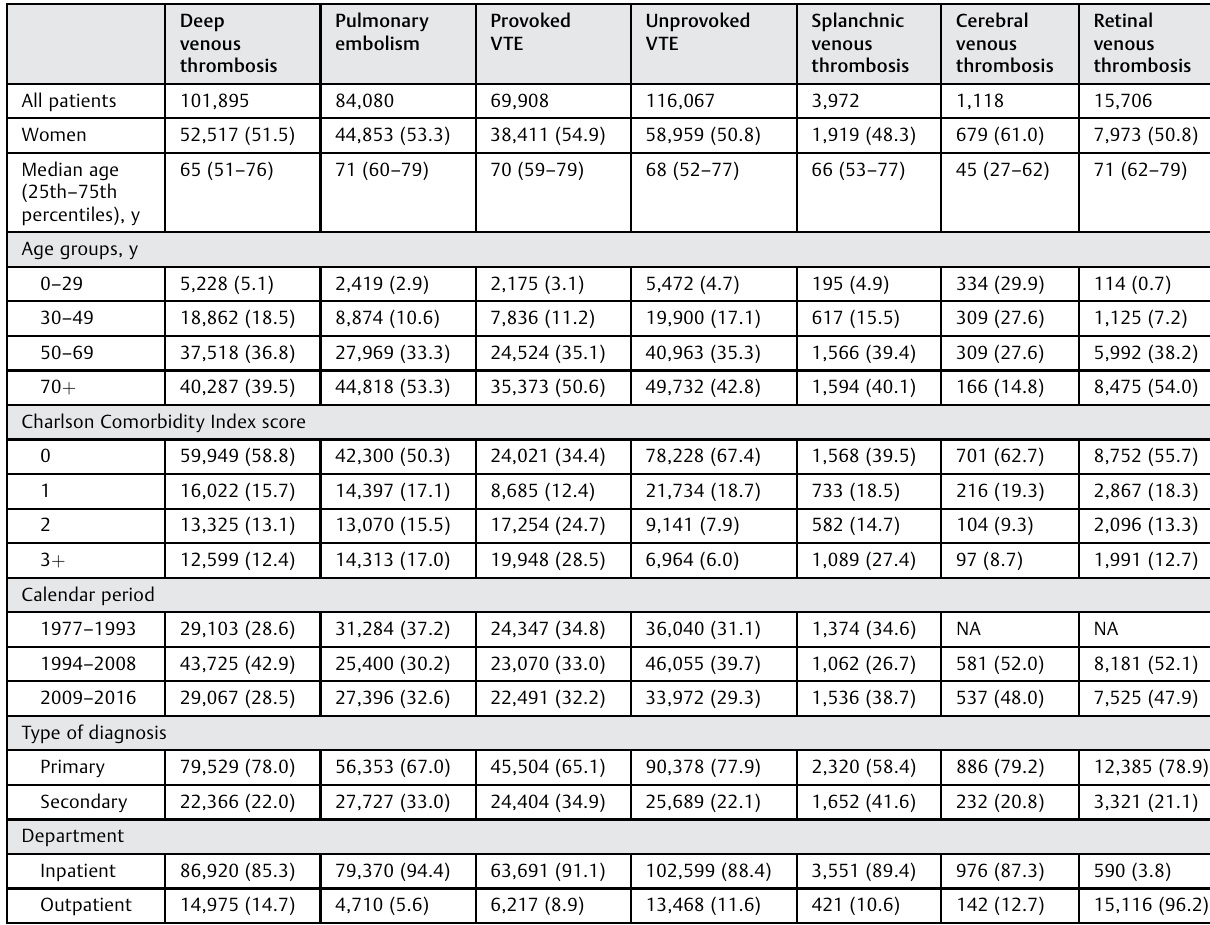
Table 1 Characteristics (no., %) of patients with deep vein thrombosis, pulmonary embolism, provoked VTE, unprovoked VTE, and splanchnic vein thrombosis during 1977 – 2016, and cerebral vein thrombosis and retinal vein thrombosis during 1994 –